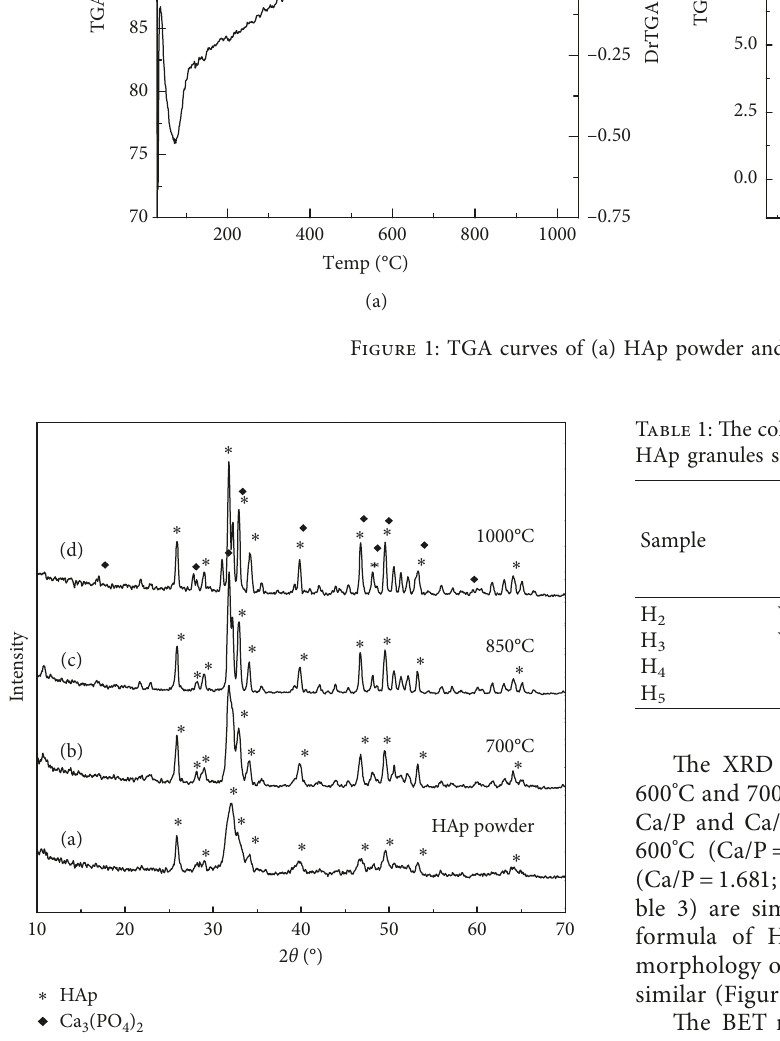
Figure 2: XRD patterns of (a) HAp powder, after sintering at (b) 700 ° C, (c) 850 ° C, and (d) 1000 ° C.